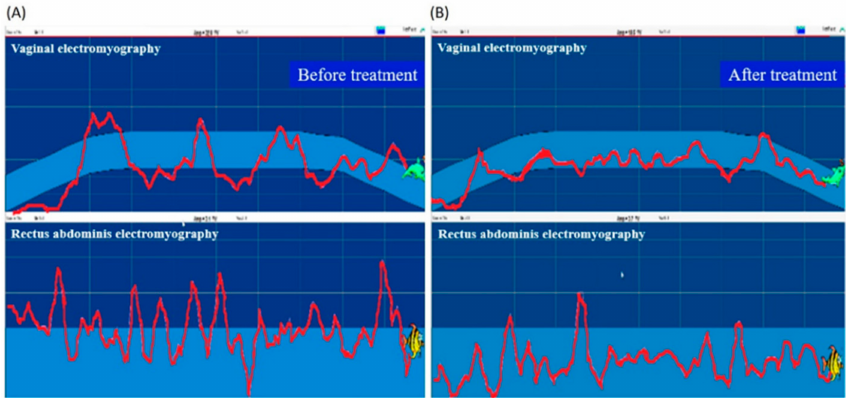
Figure 1. An illustration of the biofeedback mode during the treatment process. ( A ) Before the rehabilitation program. ( B ) After the rehabilitation